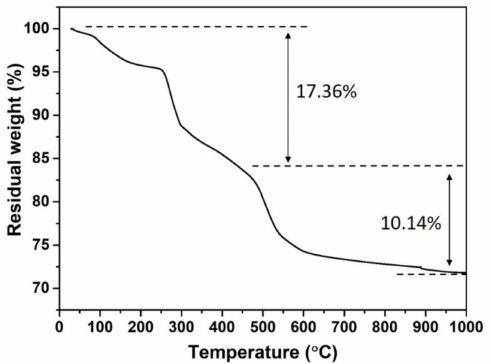
Figure 2. TG curves of the product obtained at 80 ◦ C for 24 h in the solution with a pH value of 7.34.